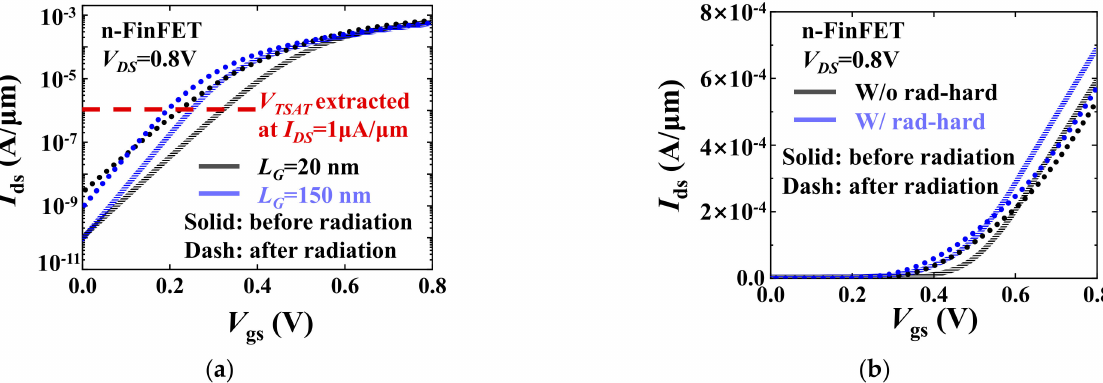
Figure 7. Comparison of the ( a ) log scale and ( b ) linear scale transfer characteristics’ drift caused by the total dose radiation in long channel ( L G = 150 nm) and 14 nm node ( L G = 20 nm) SOI